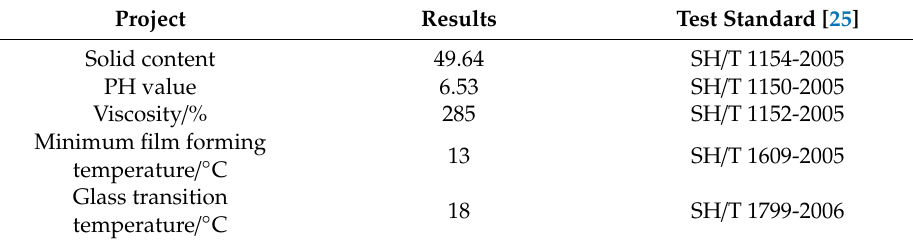
Table 5. Carboxyl styrene-butadiene latex technical indicators.